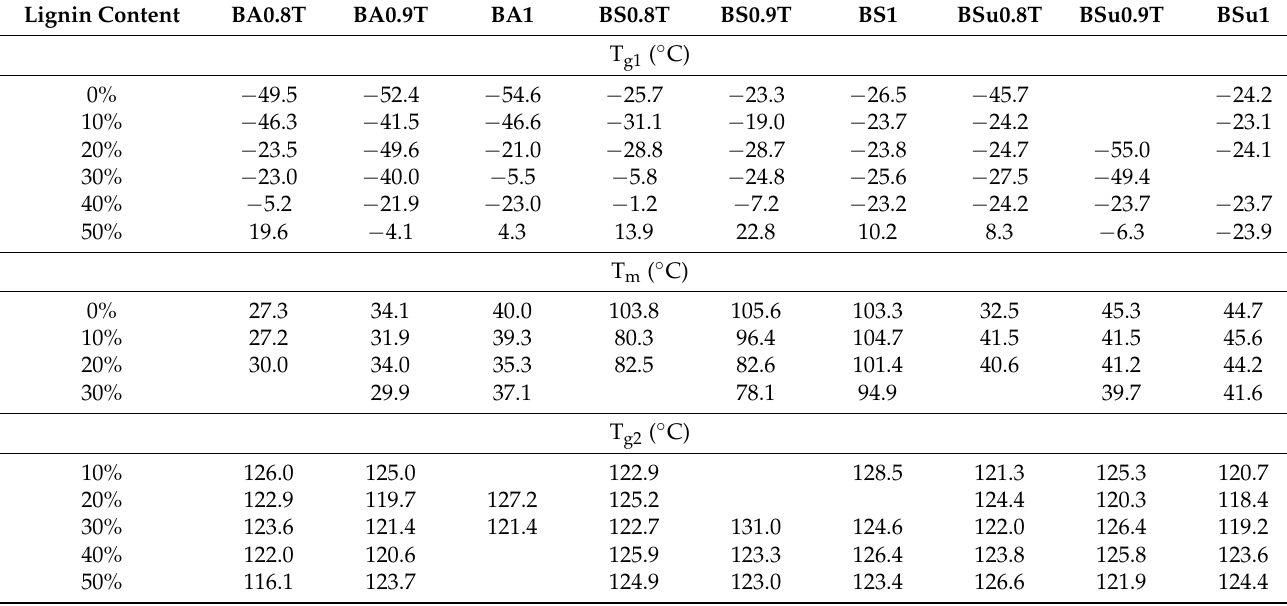
Figure 5. ( a ) DSC thermograms (1st heating cycle) of BA1-0-50%lignin copolymers (endotherm down) and ( b ) plot of glass transition temperature (T g1 ) versus lignin content for BA1, BA0.8T, BA0.9T lignin-copolymer. Table 4. Thermal transitions (T g and T m ) for the various lignin-copolymers determined by DSC. Lignin Con-